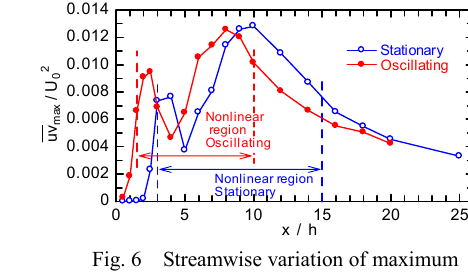
Fig. 5 Streamwise variation of maximum Fig. 6 Streamwise variation of maximum fluctuating velocities. Reynolds shear stress